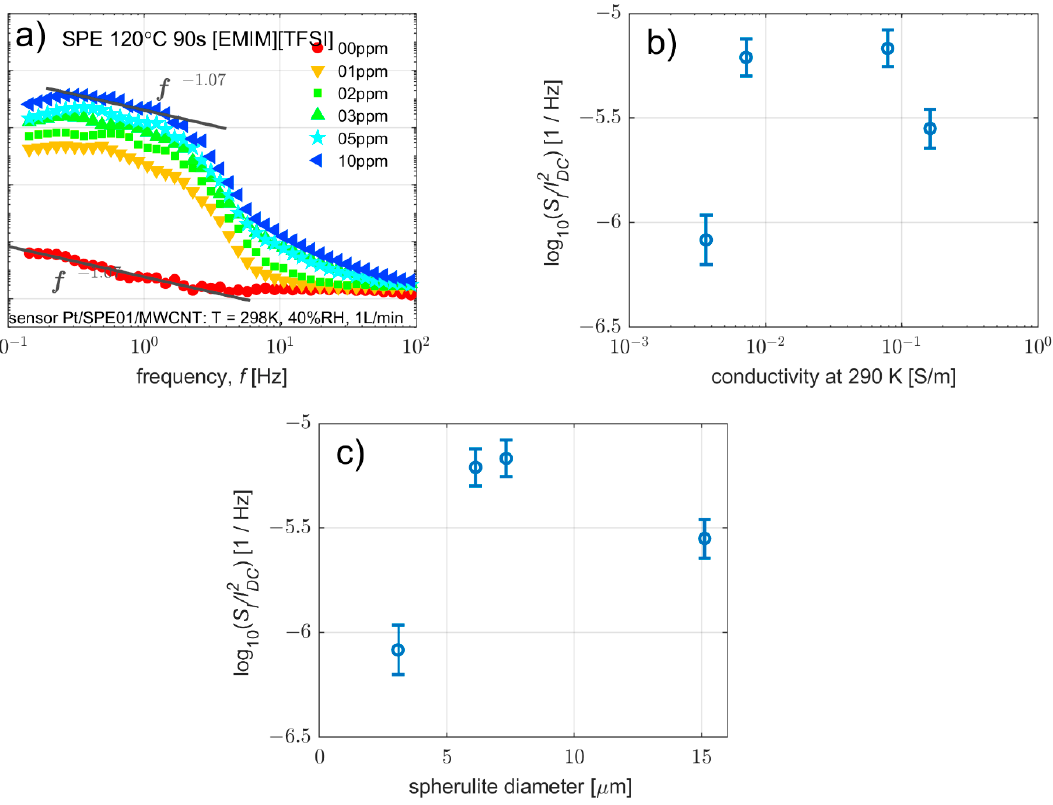
Figure 9. Effect of carbon working electrode and polymer electrolyte with various microstructures on current fluctuations of particular sensor: ( a ) Spectral density of current fluctuations for all measured NO 2 concentrations (sensor with SPE prepared at 120 °C for 90 s), ( b ) ratio of the spectral density of current fluctuations at 1 Hz to the square of the direct current as a function of electrolyte conductivity, ( c ) ratio of spectral density of current fluctuations at 1 Hz to the square of the direct current as a function of electrolyte—spherulite diameter.